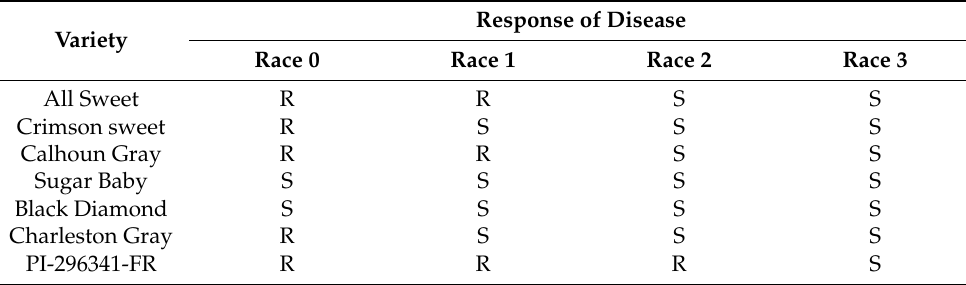
Table 1. Different watermelon varieties used to separate four races of Fon.